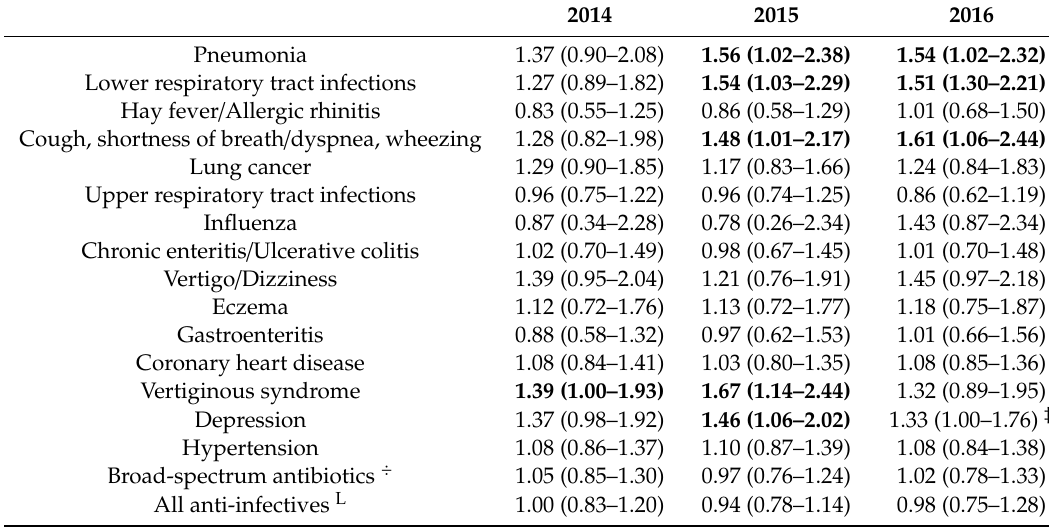
Table A17. Di ff erences (OR, 99% CI) a per year between livestock dense areas and control areas among ACOS patients (alternative definition) b (statistically significant results in bold)